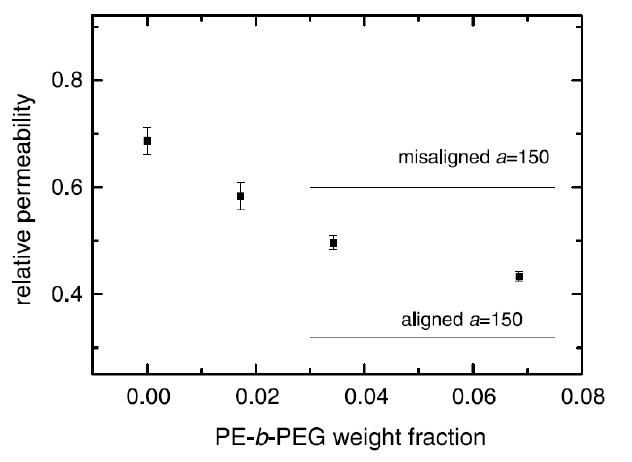
Figure 42. Relative oxygen permeability through the polyethylene nanocomposite films as function of block copolymer compatibilizer amount in the composite. Reproduced from reference [136] with permission from